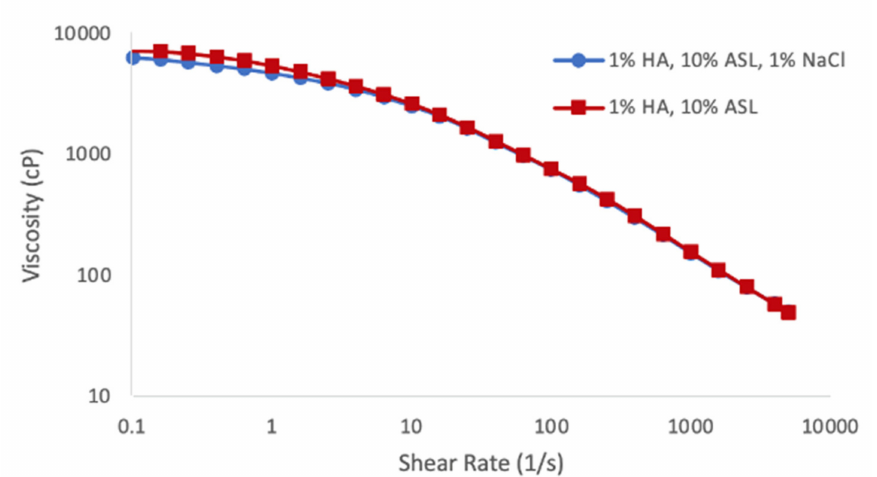
Figure 5. Effect of NaCl concentration for HA + ASL on viscosity vs. shear